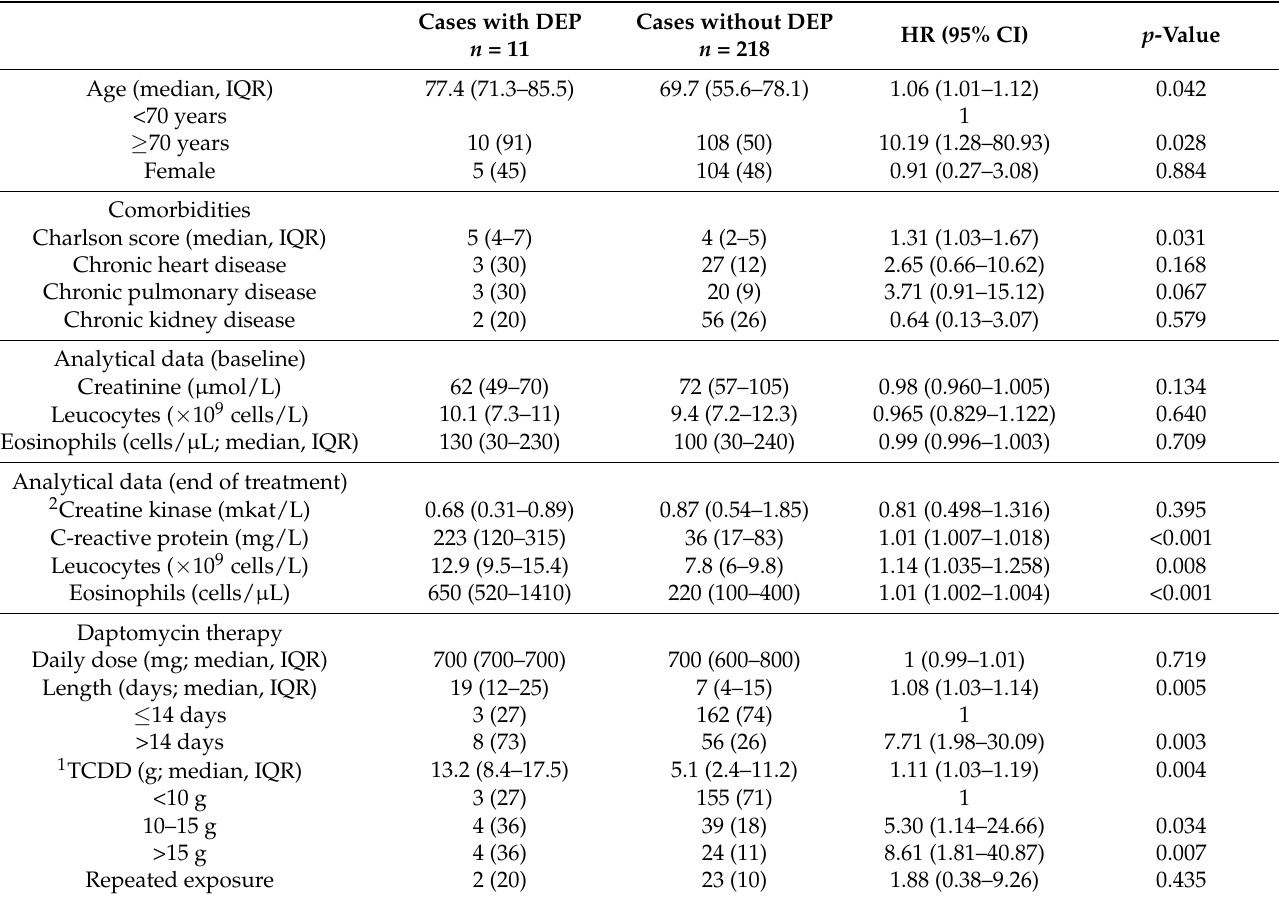
Table 1. Analysis of risk factors for daptomycin-induced eosinophilic pneumonia (DEP). Cases with